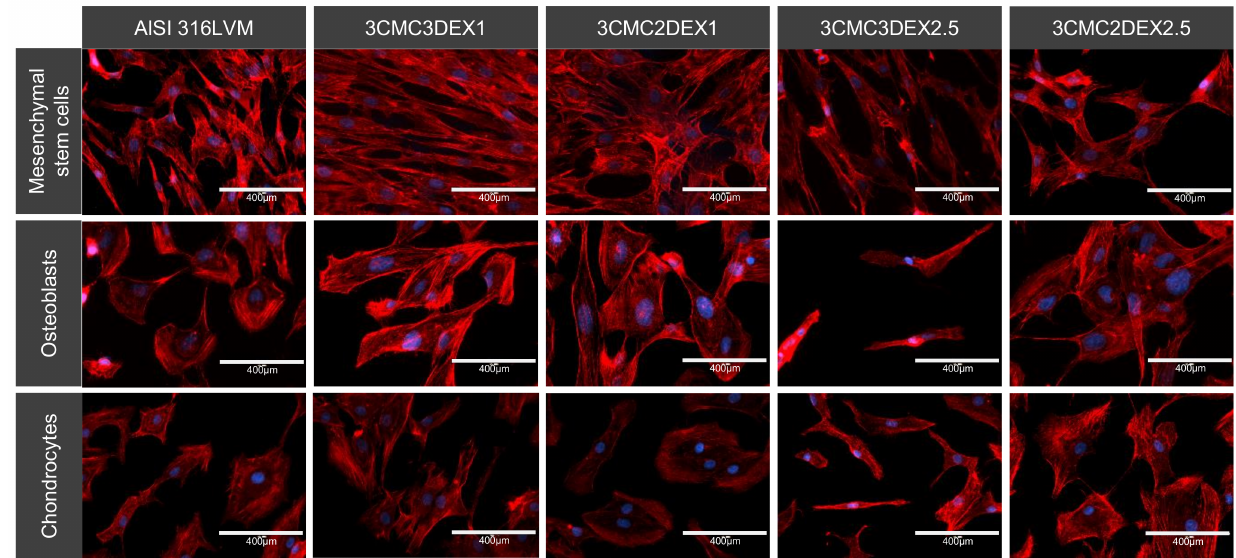
Figure 9. Representative images of the cell morphology and adhesion of different cell types cultured on four different CMC/DEX-coated substrates and controls (AlSI 316LVM) analysed by F-actin staining (red) and visualised with fluorescent microscopy. Cell nuclei were stained with DAPI